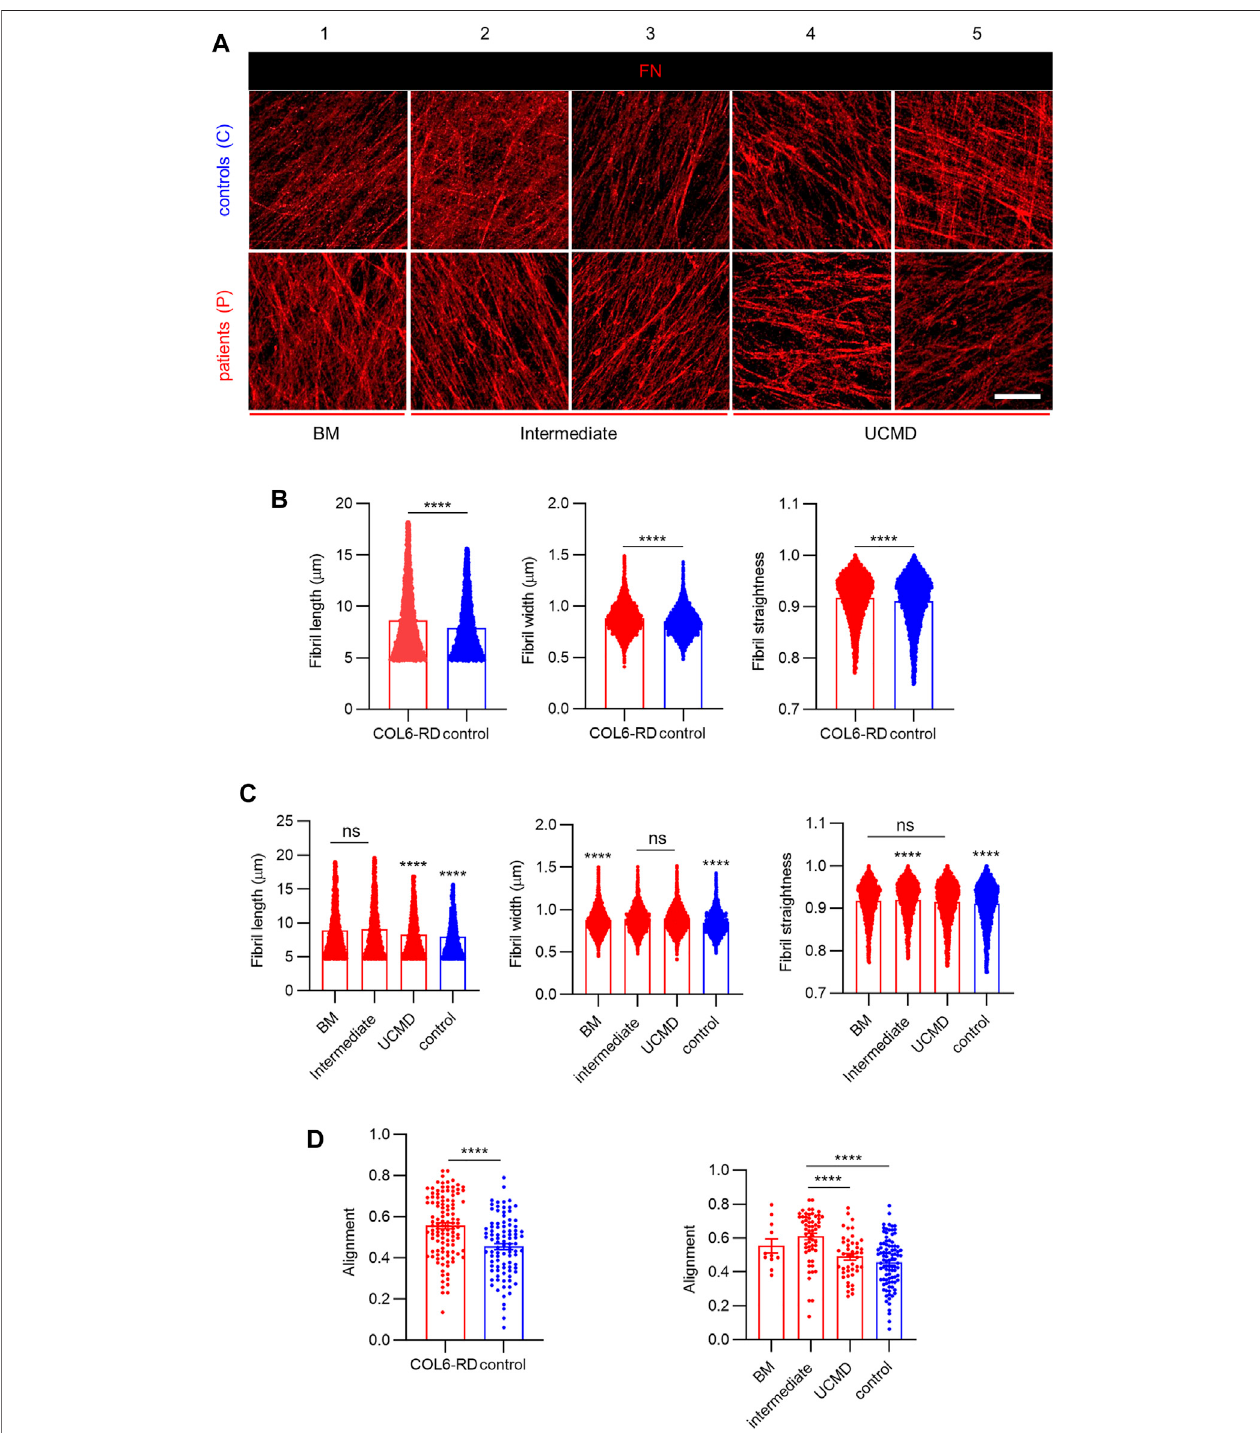
FIGURE3| AnalysisofFN fi brilsdistributionand morphologyintheCDMs. (A) RepresentativeimagesshowingtheimmunostainedFN fi brils obtainedintheCDMs fromhealthydonors(controls)andfrompatientswithCOL6-RDs.Scalebar:20 µm. (B,C) Quanti fi cationofFN fi brillength.4270 ≥ n ≥ 9042,width.4815 ≥ n ≥ 9928,and straightness. 4654 ≥ n ≥ 9633, and (D) Quanti fi cation of fi brils alignment in CDMs. 11 ≥ n ≥ 94, through computational analysis. Two microscope fi elds of view were analyzed per replicate of at least 2 replicates per donor. Results are the mean ± SEM. ns = non-signi fi cant, **** p < 0.0001.